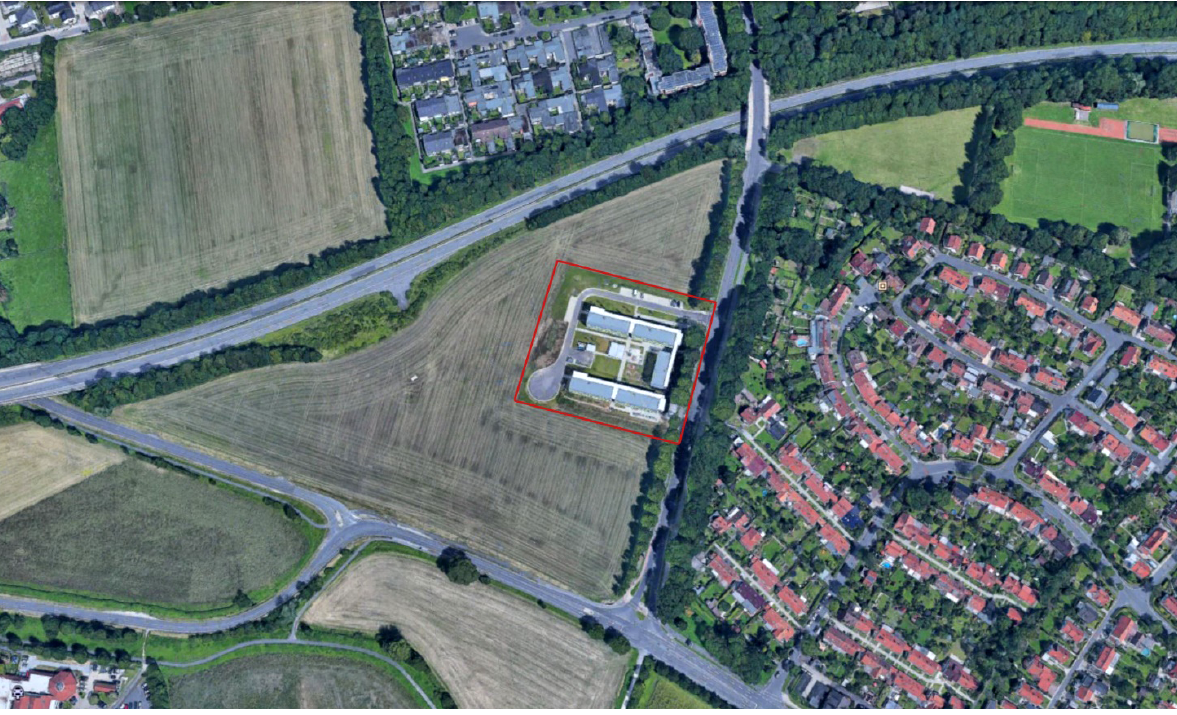
Figure 5. Purpose-built refugee accommodation/housing project, designed with five buildings and six-person apartments. Source: author. Aerial view retrieved from Google Earth on 31 October